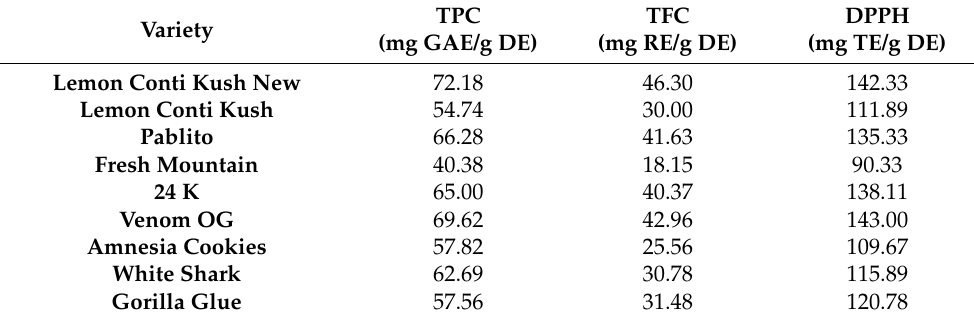
Table 5. TPC, TFC, and antioxidant activity results for the nine commercial varieties’ LE.